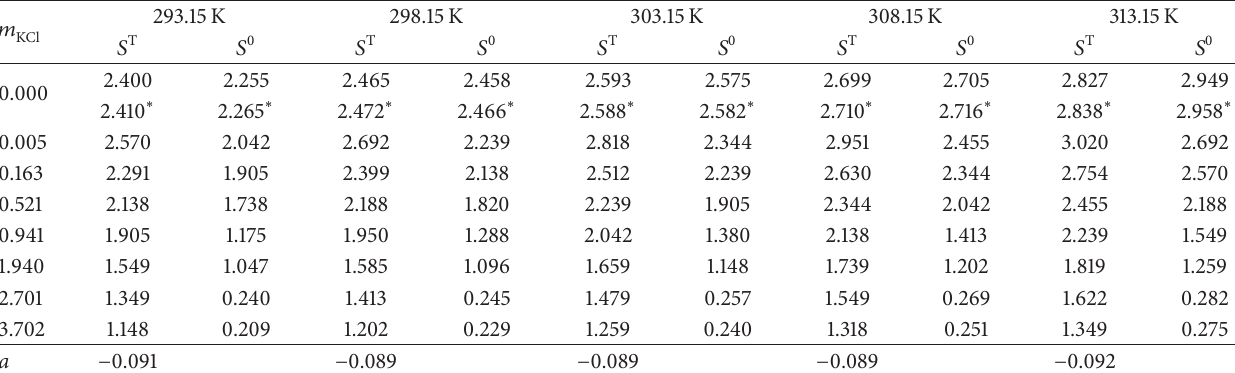
Table 6: Total solubilities 𝑆 T × 10 −3 , mol/kg −1 (and solubilities of neutral species, 𝑆 0 × 10 −3 , mol/kg −1 ), of L3 at different ionic strength of aqueous KCl and at different